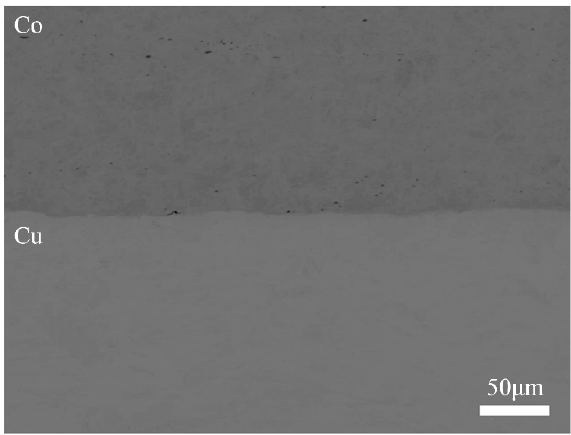
Figure 1. Cross-section of the diffusion couple before annealing.